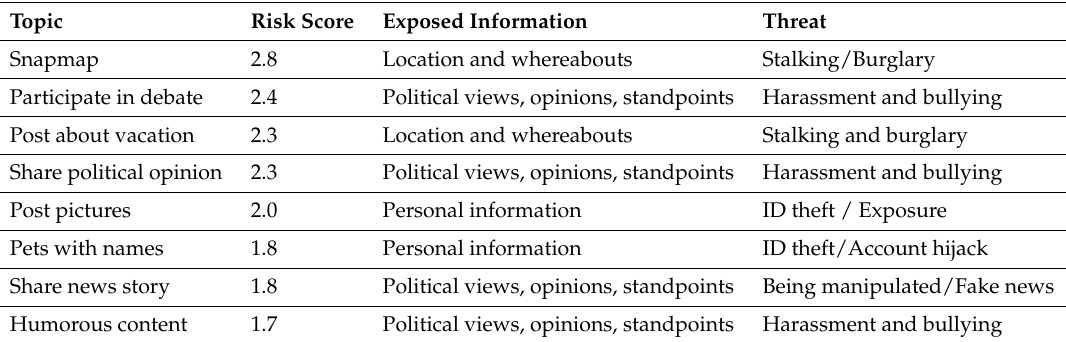
Table 29. Proposed threat model for social media (SoMe)